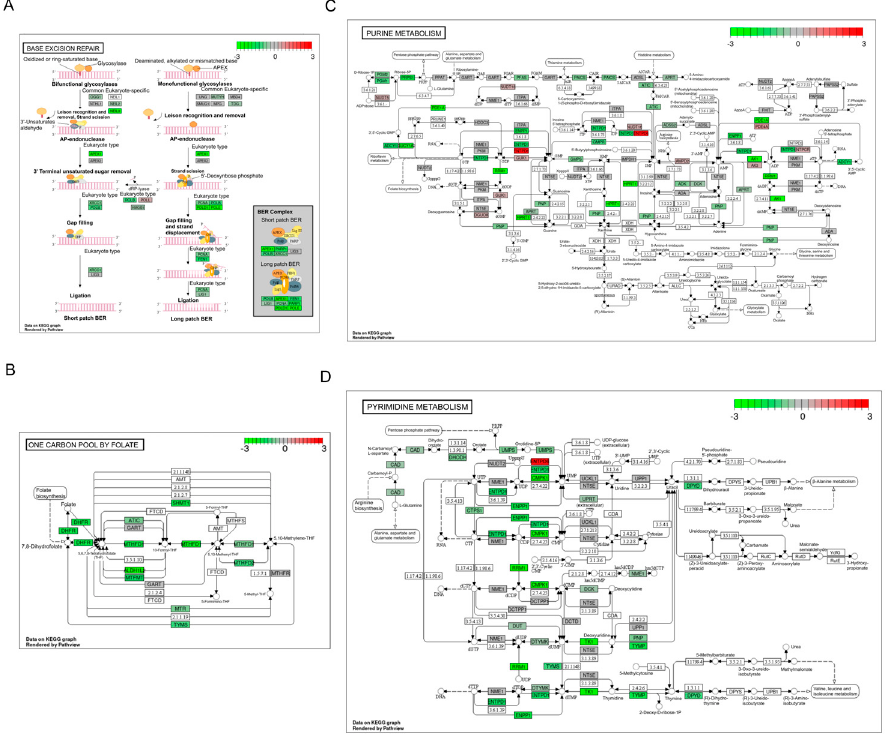
Figure 2. Signaling pathways profoundly affected by APEX1 KD in HRECs. Color-coded FCs for individual DEGs involved in significantly overrepresented KEGG pathways: ( A ) base excision repair (BER), ( B ) one carbon pool by folate, ( C ) purine metabolism, and ( D ) pyrimidine metabolism.